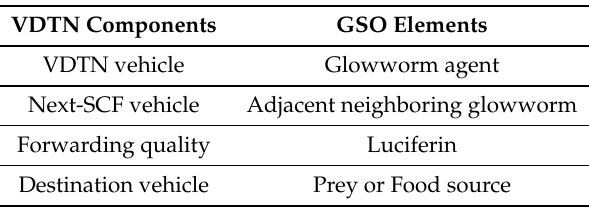
Table 2. VDTN/GSO